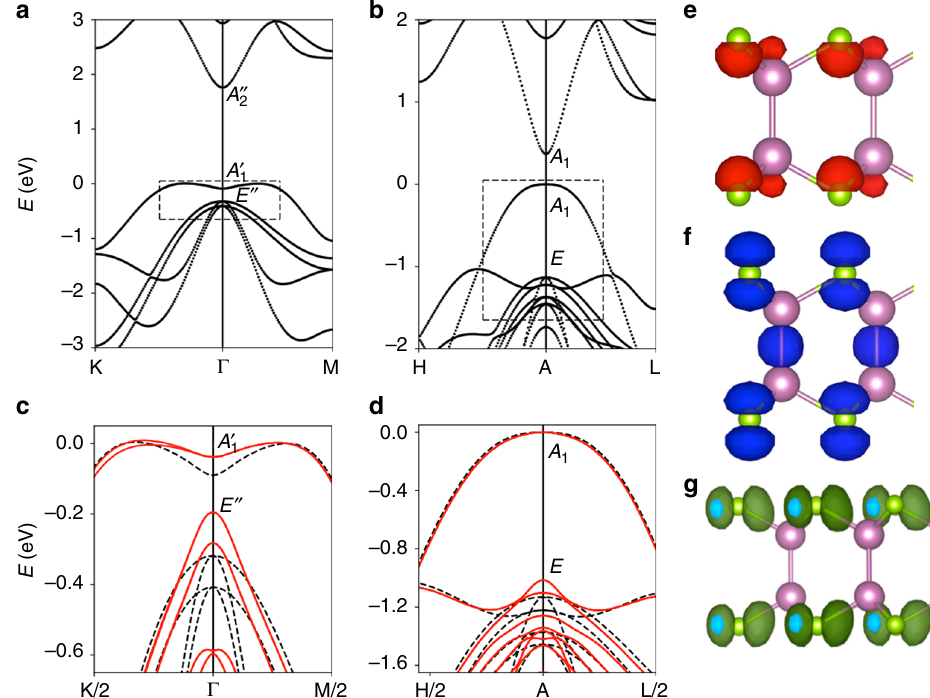
Fig. 4 Electronic properties of InSe. Electronic band structure of a monolayer (ML) and b bulk InSe along the K- Γ -M and H-A-L high symmetry directions of the hexagonal Brillouin zone 25 , respectively. Note that electronic states along K- Γ -M directions are equivalent to these along H-A-L high symmetry directions in the case of ML InSe. The symmetry of initial and fi nal states relevant for optical transitions is indicated in the plots. Details of the electronic structure at the top of the valence band for c ML and d bulk InSe, including the calculations without (black dashed lines) and with spin – orbit coupling (red solid lines). Wave functions at Γ point for ML InSe corresponding to states at: e bottom of the conduction band ( A ″ 2 ), f top of the valence band A ′ top of the second highest valence band ( E ″